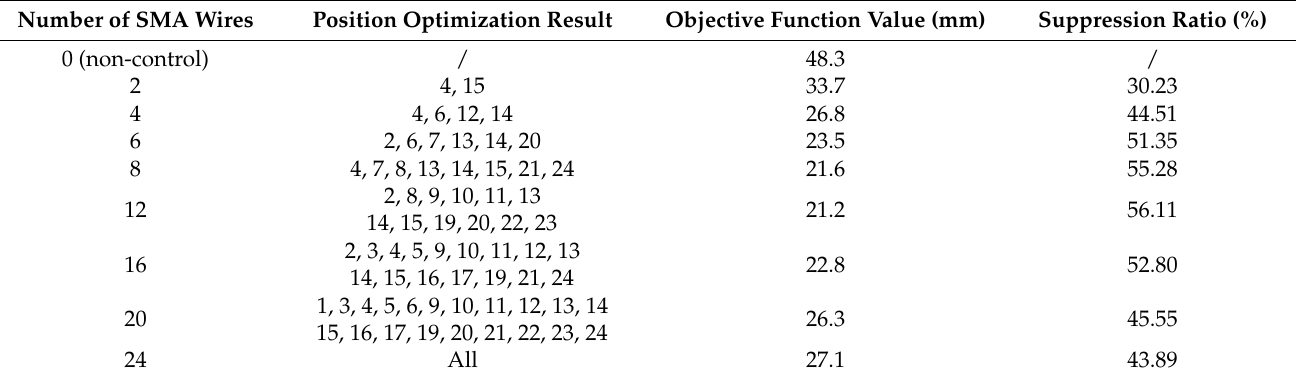
Table 5. Optimal results of austenite SMA wires with different